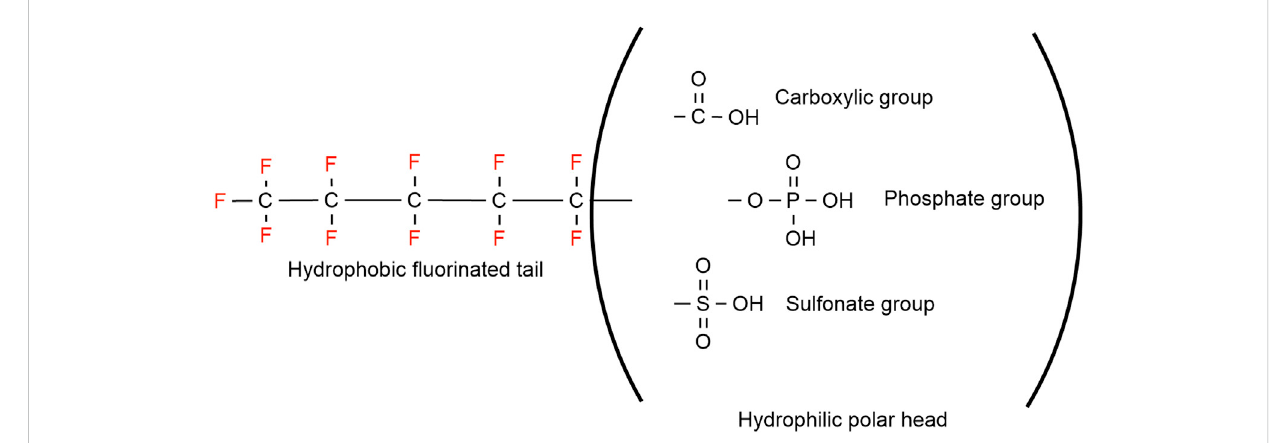
FIGURE 1 General structure of non-polymeric, per fl uorinated PFAS